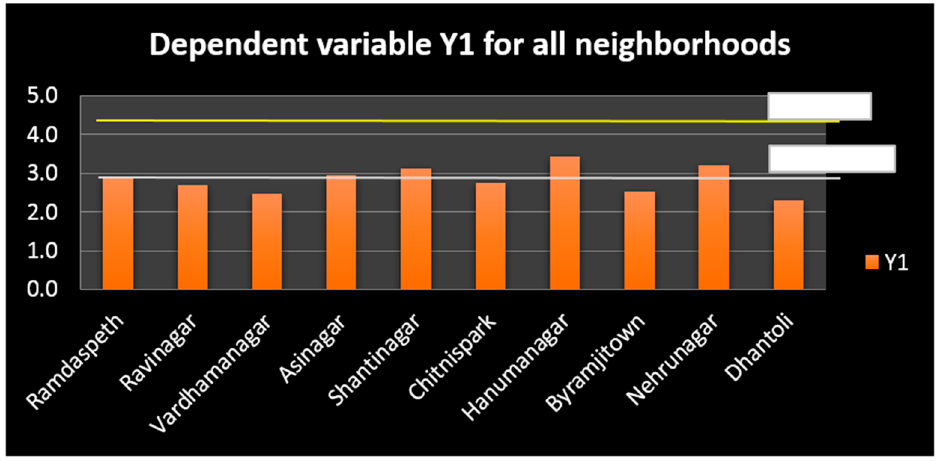
Figure 20. Showing the satisfaction variable for all neighborhoods in Nagpur.